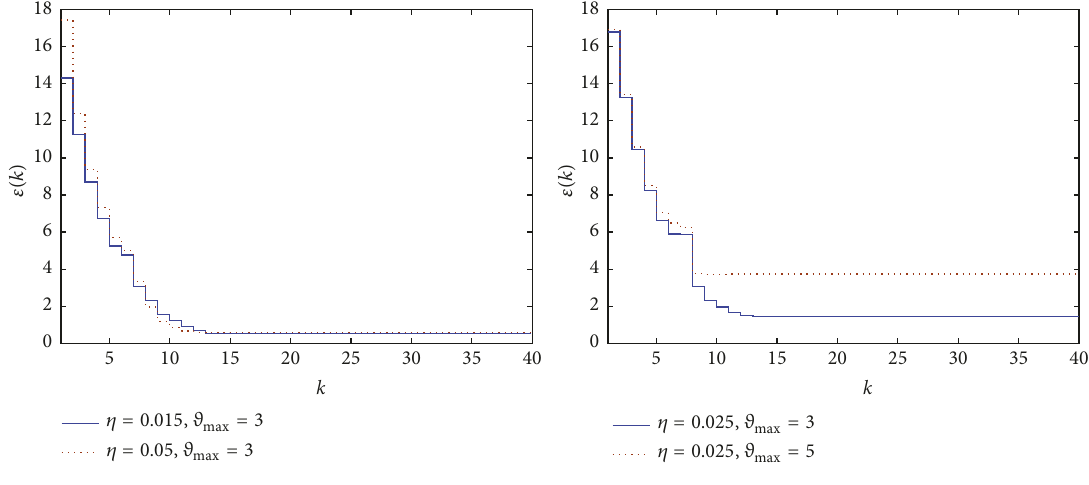
Figure 8: Evolutions of 𝜀(𝑘)